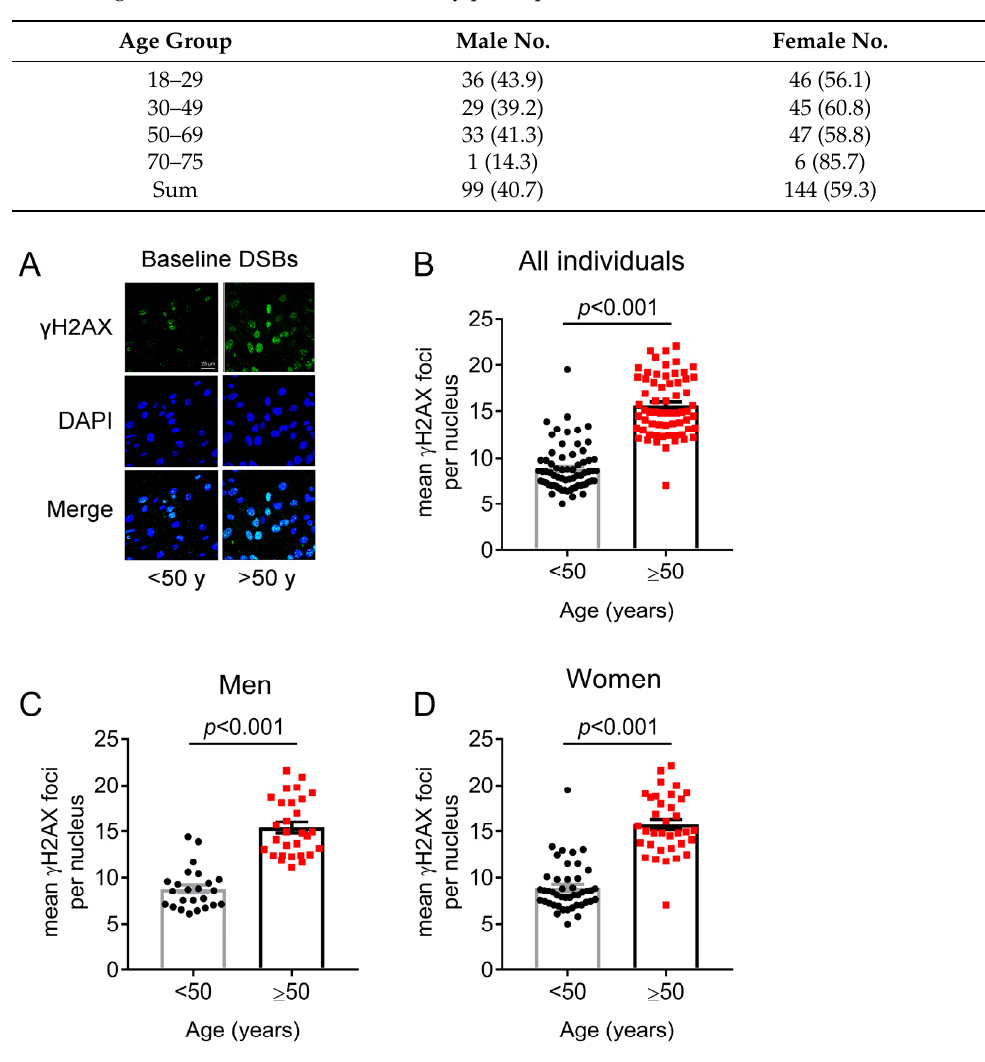
Figure 2. Endogenous DNA double-strand break levels in PBMCs. ( A ) Representative confocal mi- croscopy images showing γ H2AX staining from an individual under the age of 50 years (37 years old) and an individual over the age of 50 years (61 years old). Upper images, immunofluorescence γ H2AX staining; middle, cell nuclei labeled with DAPI; bottom, merged (scale bar: 25 µ m). ( B – D ) Endogenous DNA double-strand breaks assessed by γ H2AX immunofluorescence staining in PBMCs of individuals younger or older than 50 years in the whole study population (mean ± SEM: <50 = 8.9 ± 0.3; ≥ 50 = 15.6 ± 0.4) ( B ), only in men (mean ± SEM: <50 = 8.8 ± 0.5; ≥ 50 = 15.4 ± 0.6) ( C ), and only in women (mean ± SEM: <50 = 8.9 ± 0.4; ≥ 50 = 15.8 ± 0.6) ( D ). The p -values are derived from Mann–Whitney U test. Bars and error bars represent mean and standard error of the mean (SEM).